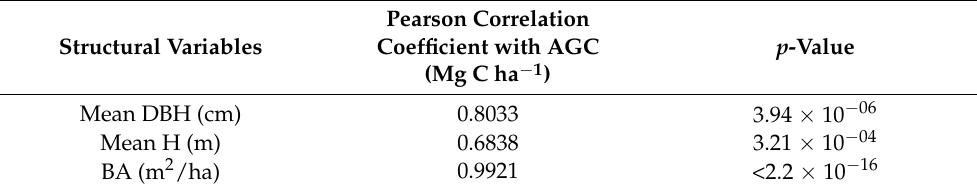
Table 5. Pearson’s correlation coefficients between aboveground carbon (AGC) density and structural parameters of the